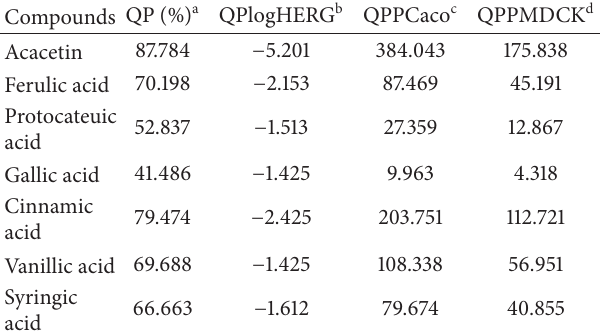
Table 2: ADME profiles predicted for the polyphenolic